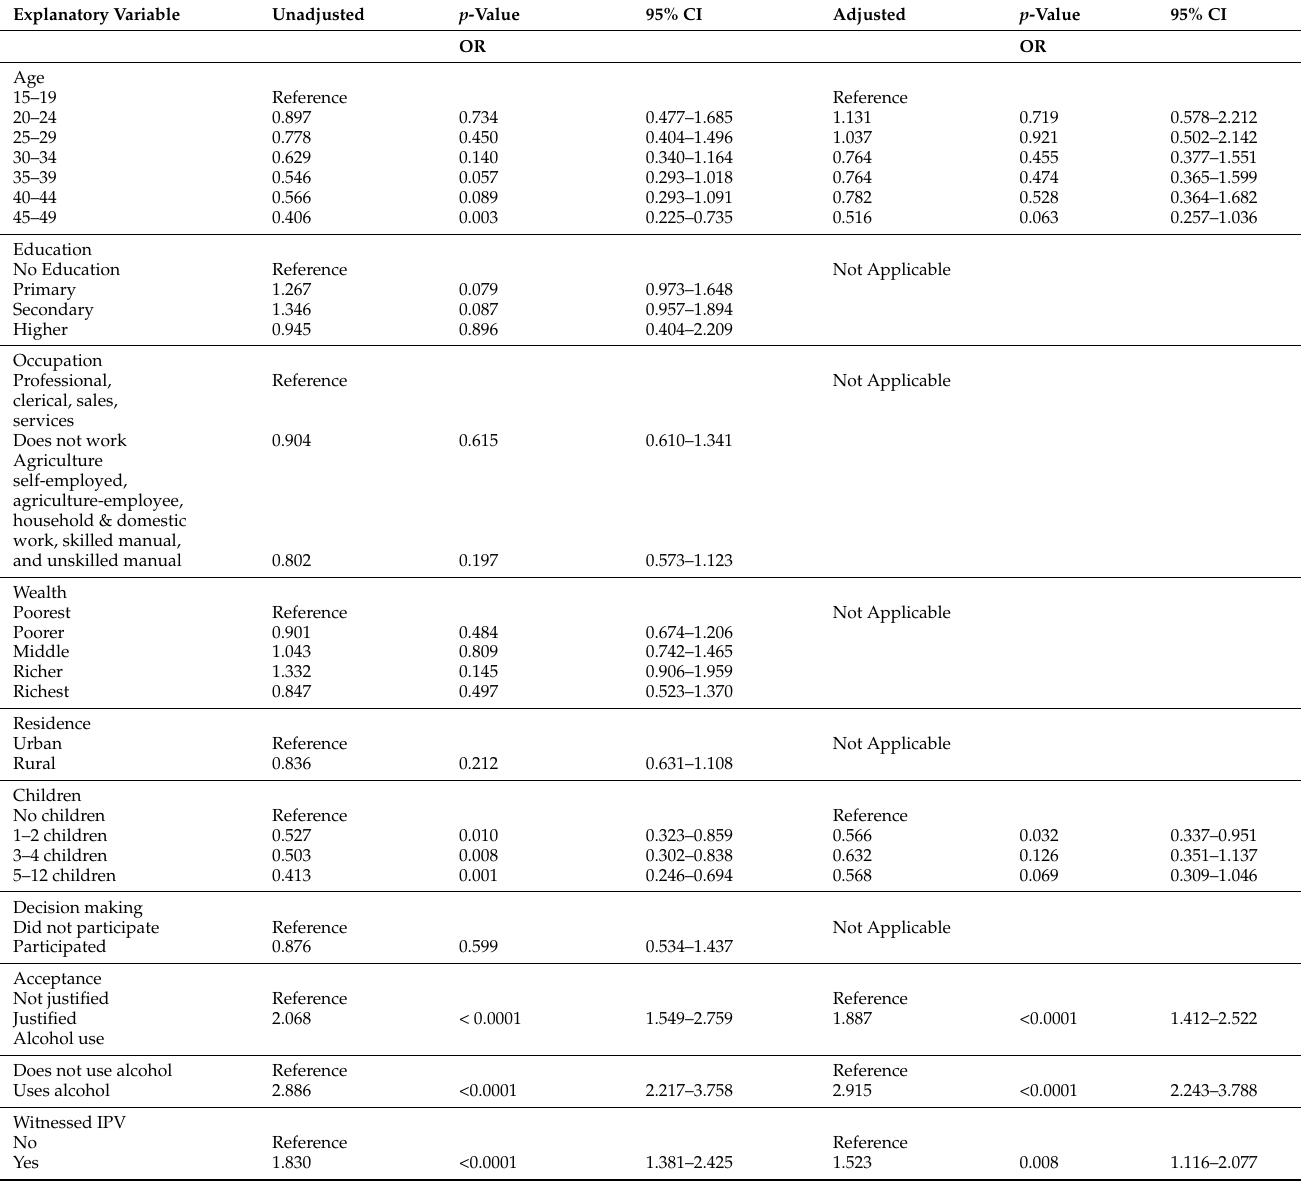
Table 2. Crude odds ratios and adjusted odds ratios for all statistically significant associations between intimate partner violence and the selected variables—Liberia DHS